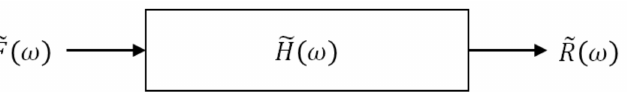
Figure 2. Relationship between input impulse and output response in abnormal